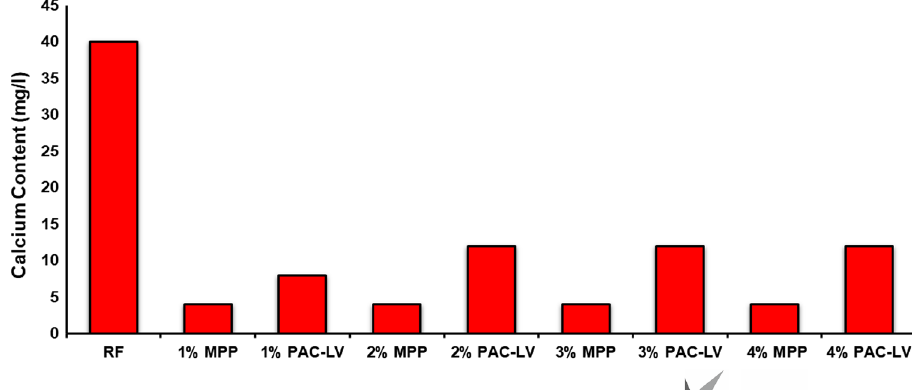
Fig. 14 The effect of MPP and PAC-LV on calcium